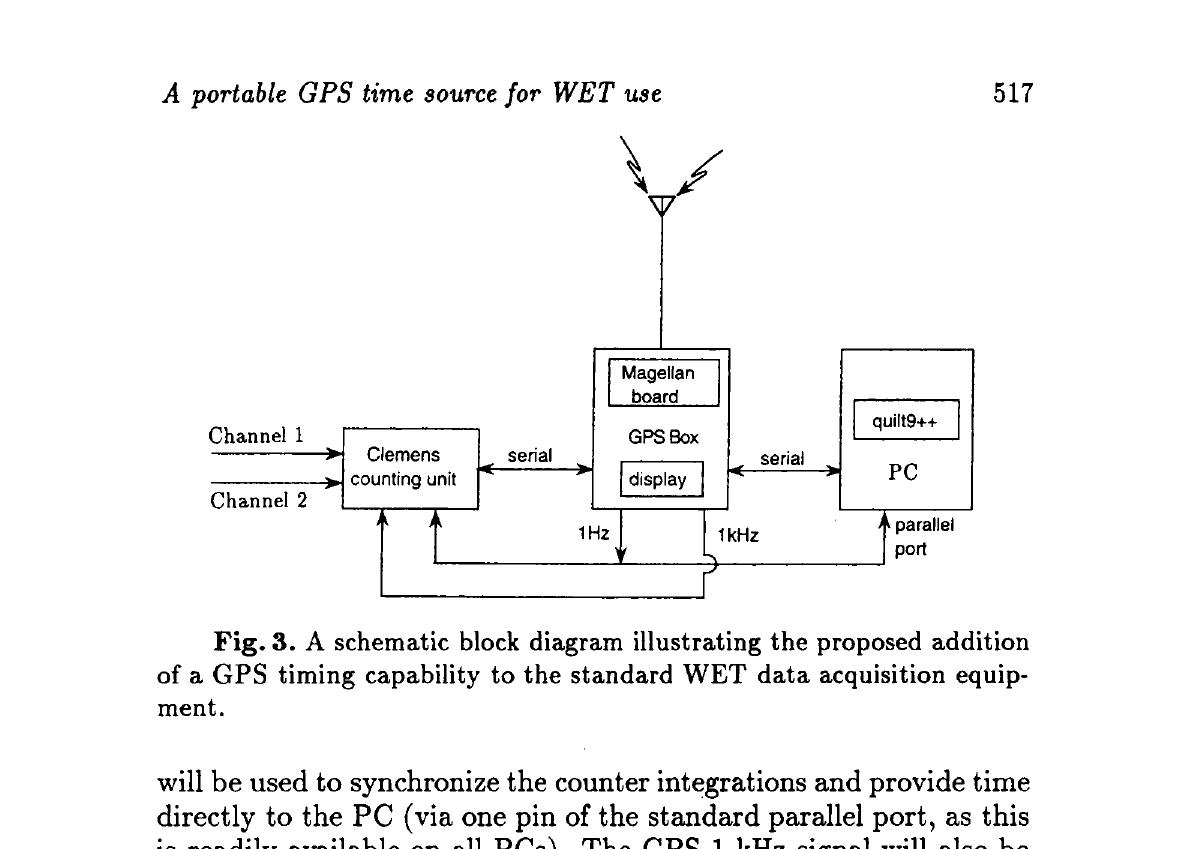
Fig. 3. A schematic block diagram illustrating the proposed addition of a GPS timing capability to the standard WET data acquisition equip-